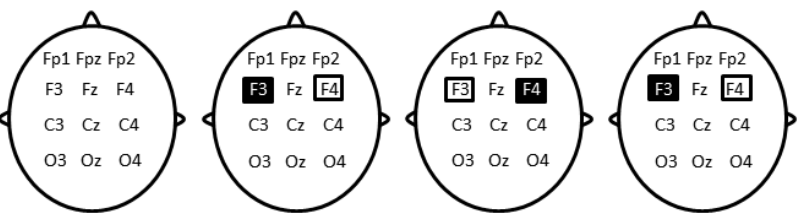
Figure 2. Schematic representation of electrodes’ position in the four conditions: (Left) TMR-only, no electrode positioned. (Left-middle) TMR-anodal left tDCS, anodal stimulation on the left DLPFC and cathodal stimulation on the right DLPFC for 20 min. (Right-middle) TMR-anodal right tDCS, cathodal stimulation of the left DLPFC and anodal stimulation of the right DLPFC for 20 min. (Right) Sham condition, anodal stimulation of the left DLPFC and cathodal stimulation of the right DLPFC for 15 s. The dark rectangle depicts the anode and the light rectangle depicts the